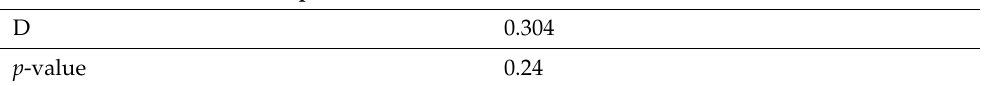
Table 2. Results of the Kolmogorov–Smirnov test (KS test) for differences between male and female distribution of septal deviation, relative to the side. D = vertical distance between the two cumulative distributions. Asterisks indicate significance: * p -value ≤ 0.05; ** p -value ≤ 0.01; *** p -value ≤ 0.001. Sample size: 46 specimens.